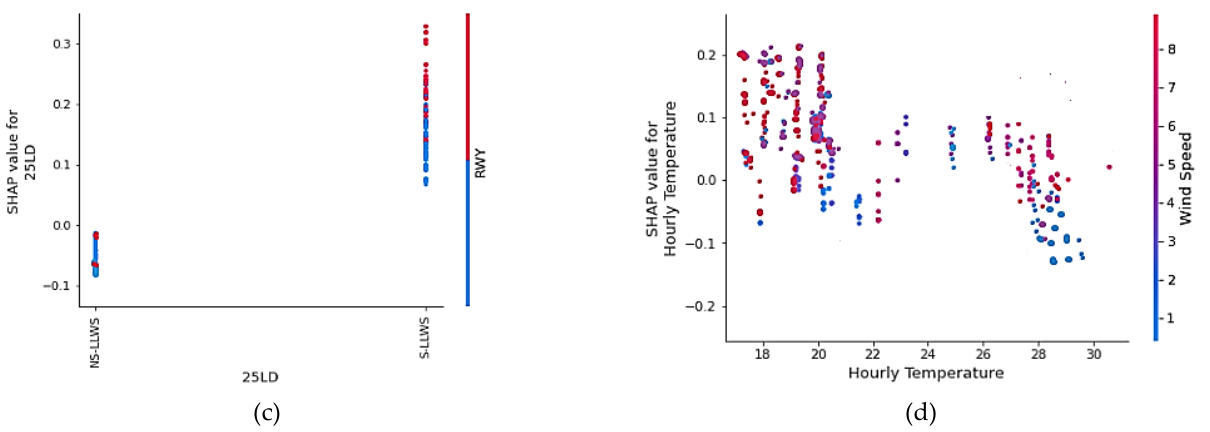
Figure 10. SHAP Interaction Plots: ( a ) Interaction of Runway 25LD and Hourly Temperature; ( b ) Interaction of Wind Speed and Runway 25LD; ( c ) Interaction of Runway 25LD and RWY (location of LLWS occurrence); ( d ) Interaction of Hourly Temperature and Wind Speed.